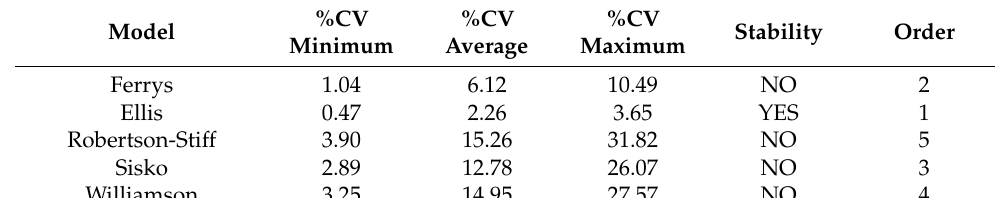
Table 5. Stability in prediction based on VF. Table 5 shows that the variability coe ffi cient of the VF for the Ellis model is less than